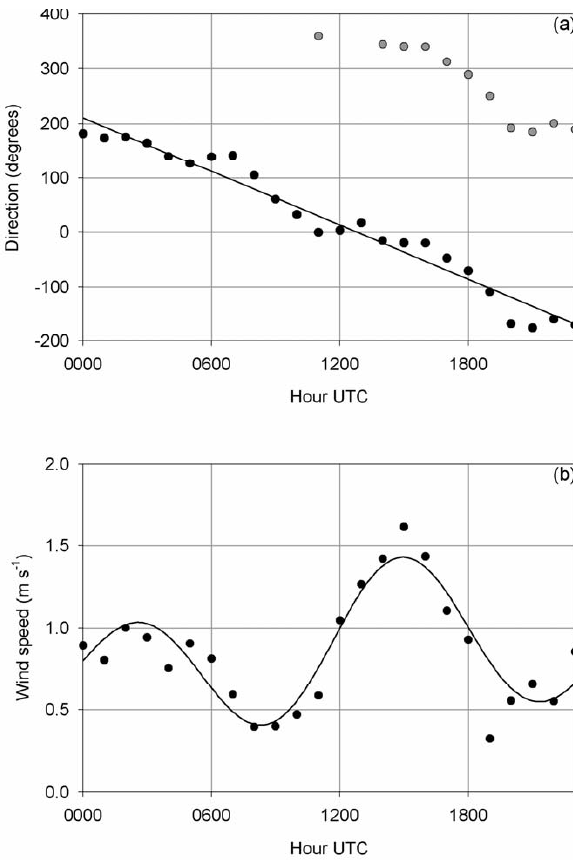
Fig. 8. (a) Daily evolution of the direction φ in the lowest level (40m). Initial values were positive, although the gap was avoided by subtracting 360 ◦ . After this transformation the trend was linear, turning anti-cyclonically. (b) Daily evolution of Fig. 8 . (a) Daily evolution of the direction φ in the lowest level (40 m). Initial values were level fitted by a second order model for cylindrical data. positive, although the gap was avoided subtracting 360º. After this transformation the trend was linear turning anti-cyclonically. (b) Daily evolution of second order model for cylindrical data.